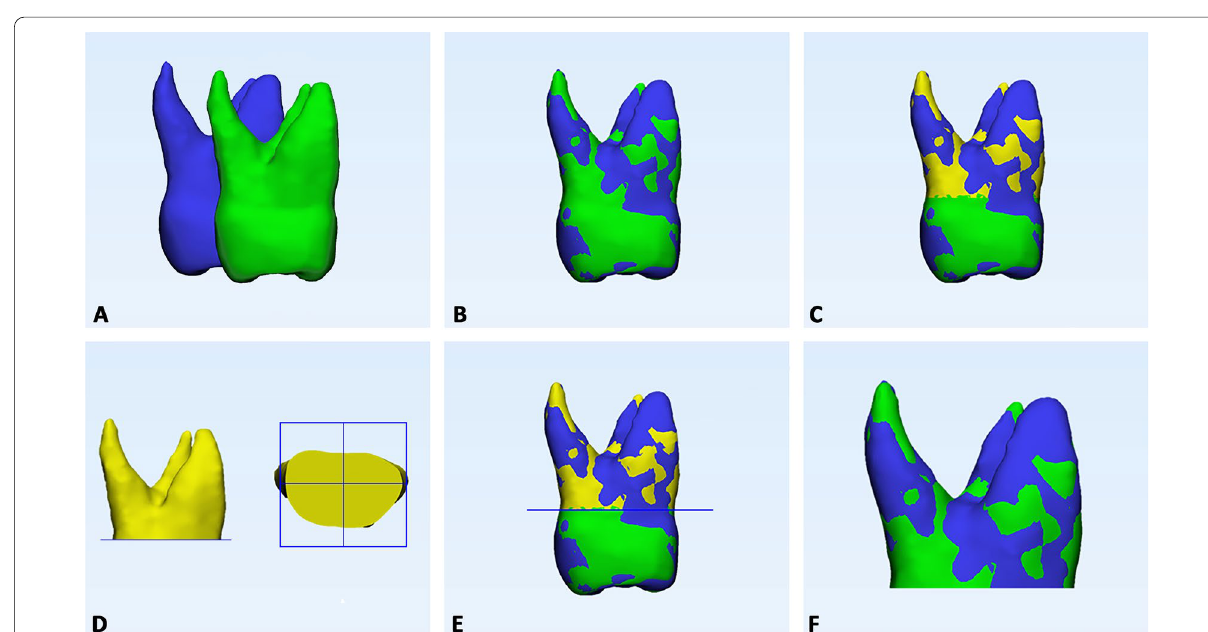
Fig. 4 Registration of T0–T1 3D tooth models and crown removal from 3D models. a Preliminary point‑based superimposition, by selecting five random points on the buccal, palatal/lingual, mesial approximal, distal approximal, and occlusal aspects of the two models of the same tooth. b Global registration using best‑fit algorithm. c T0 tooth model (blue) and radicular template (yellow) and T1 tooth model in the same spatial orientation after superimposition; d , e definition of a single plane cut by randomly selecting three points on the lower surface of the T0 radicular template; f generation of the final T0 and T1 radicular models